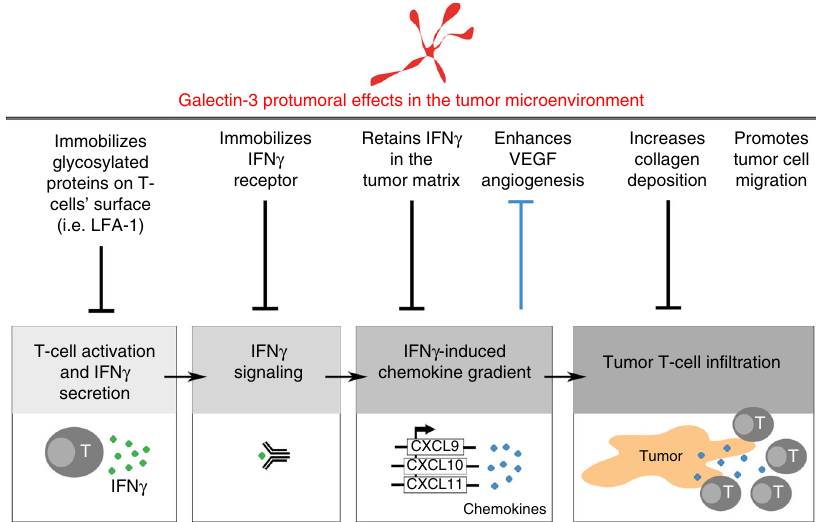
Fig. 9 Scheme summarizing the main protumoral effects known for galectin-3 in the tumor microenvironment. Galectin-3 has been described to immobilize glycosylated proteins on the surface of T cells 28, 30, 31, 32, 33 , IFN γ receptor on human fi broblasts and B cells 53 , and VEGF receptor in human endothelial cells 27 . In addition, galectin-3 favors collagen deposition by macrophages 48 and tumor cell migration 54 . This fi gure does not intend to make an exhaustive review about all the effects published for galectin-3 but to highlight the ones that, in our opinion, can be working simultaneously in the